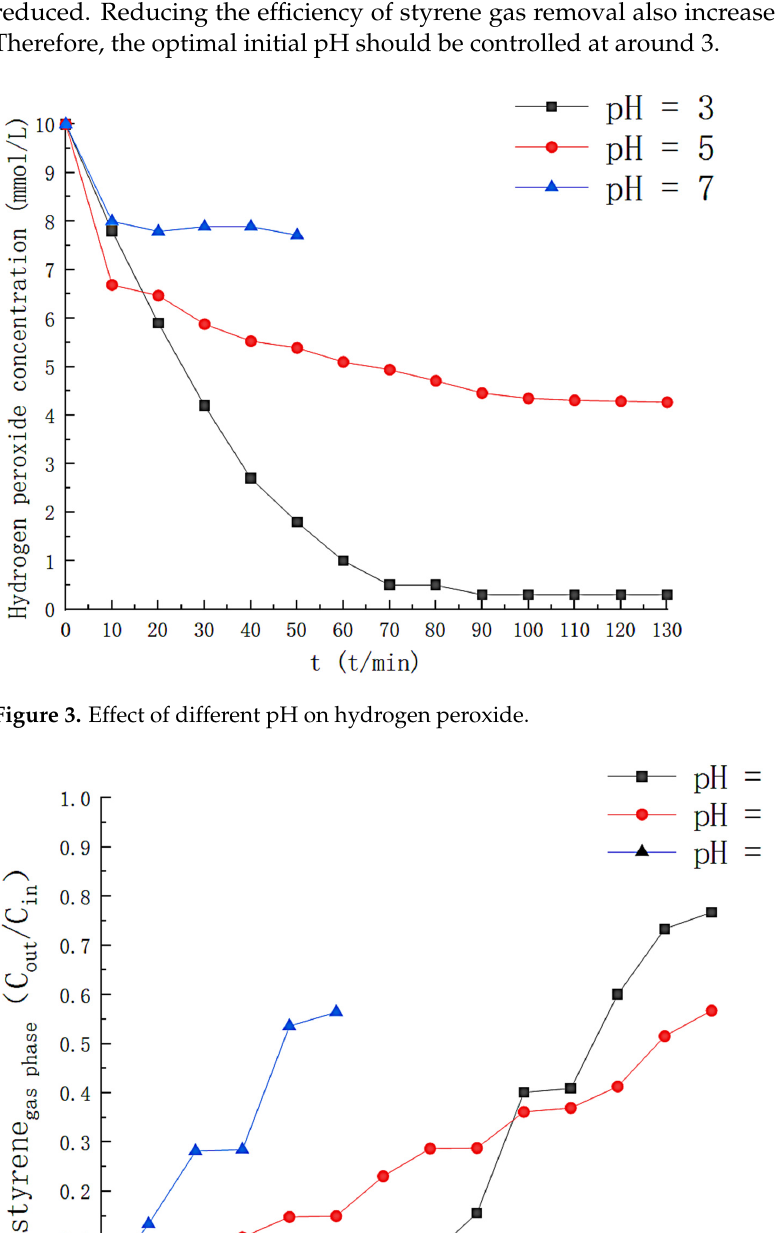
Figure 5. Effect of different pH on TOC concentration.